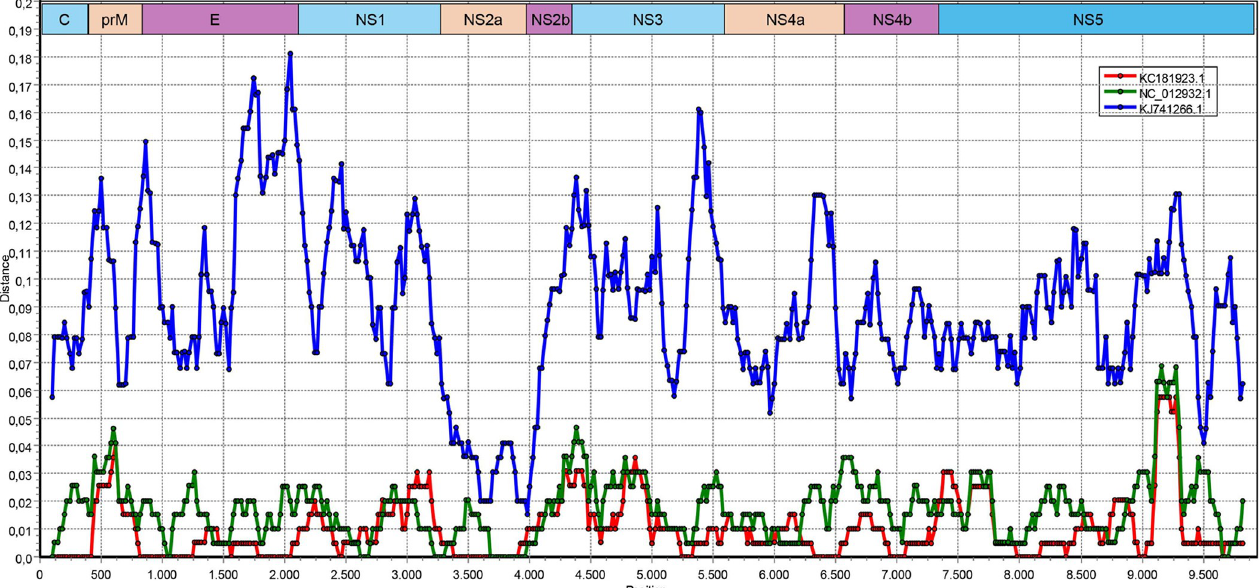
Fig 5. Plots of similarity of the near-complete polyprotein coding alignment (9931 nt) of AEFV-Turkey (MK251047), with individual functional units indicated (GapStrip: On, Reps: 1000, Kimura (2-parameter), T/t: 2.0). The curves indicate comparisons between the target and reference